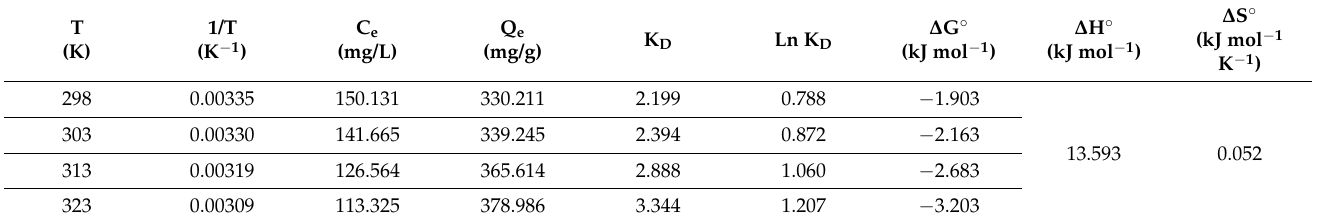
Table 5. Representation of the thermodynamic parameters ( ∆ G ◦ , ∆ H ◦ and ∆ S ◦ ) obtained by Van’t